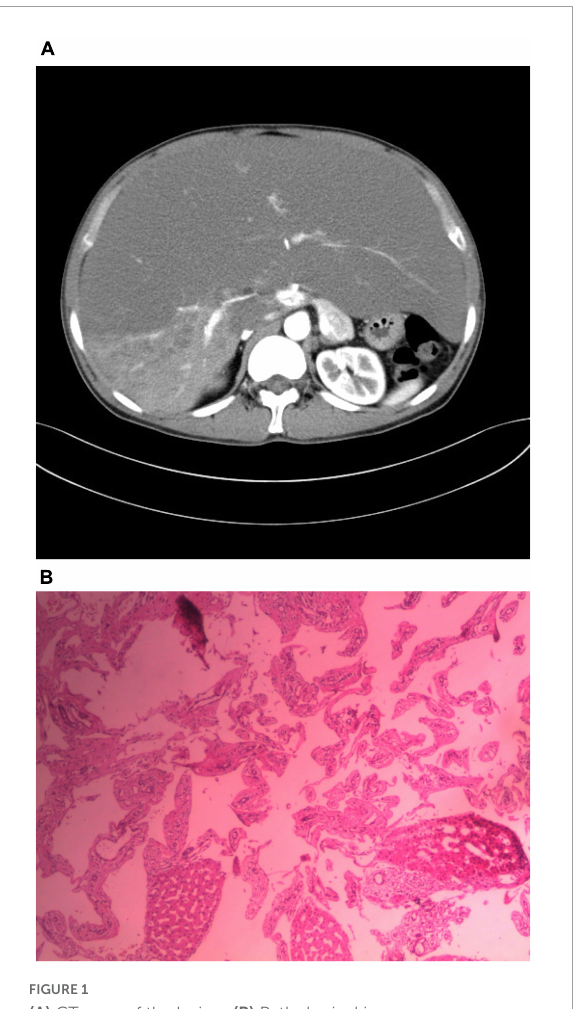
FIGURE1 (A) CT scan of the lesion. (B) Pathological